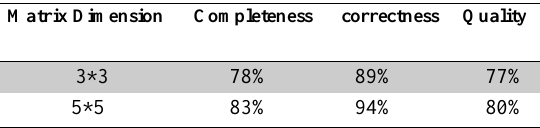
Table 1. Performance measures of different index with different matrix dimension of Test image I.